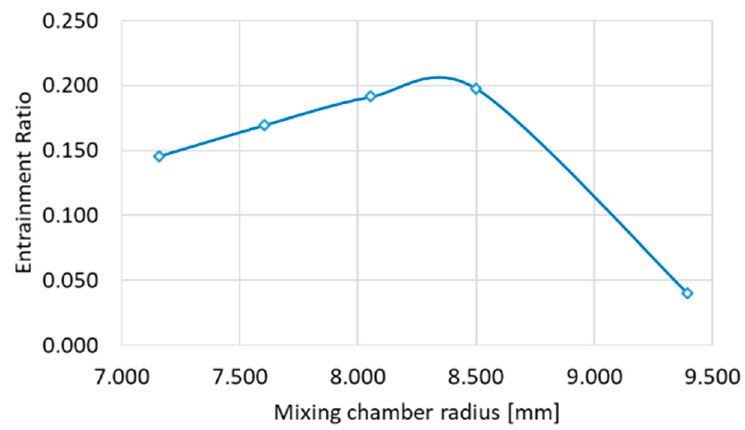
Figure 10. Area Ratio optimization for Ejector with ANSYS-FLUENT .